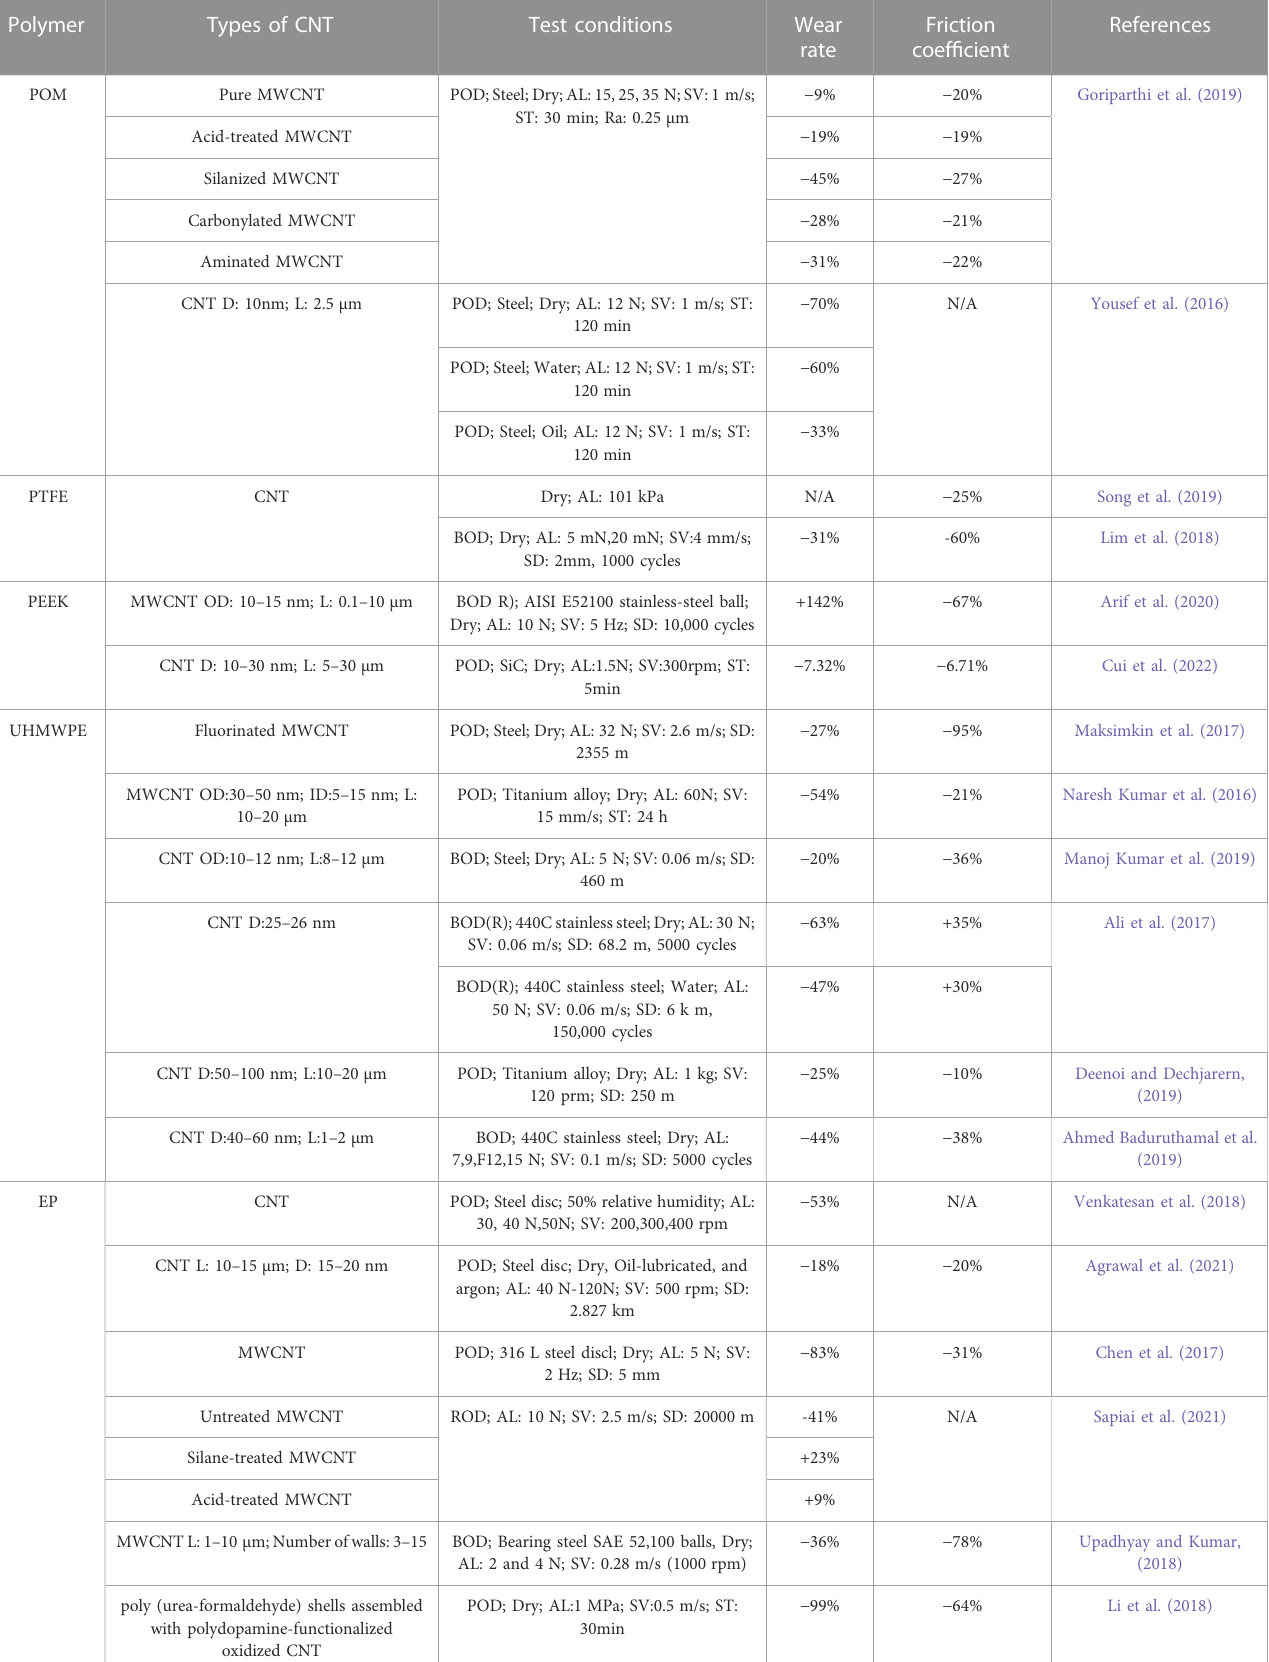
TABLE 1 Tribological properties of polymer nanocomposites based on CNT.